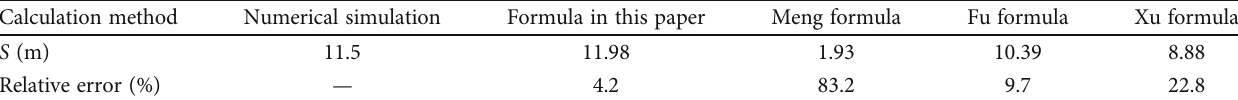
Table 2: Calculation results of the tunnel critical safety thickness S in fault fracture zone.